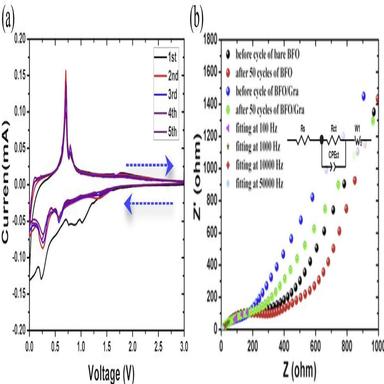
(a) Cycle-Voltammetry (CV) curves of the BFO electrode for the first five cycles. (b) Impedance spectra of the bare BFO and BFO/Gra electrode.